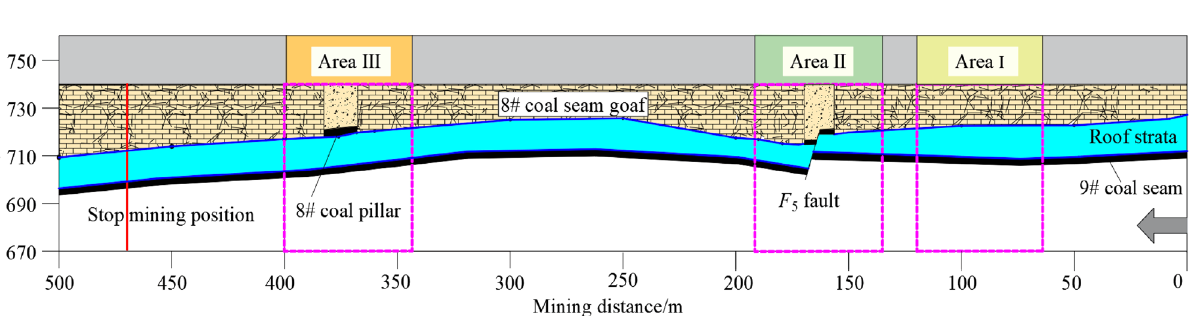
Figure 2. Mining layout of the 9101 longwall panel in the Xiashanmao coal mine.